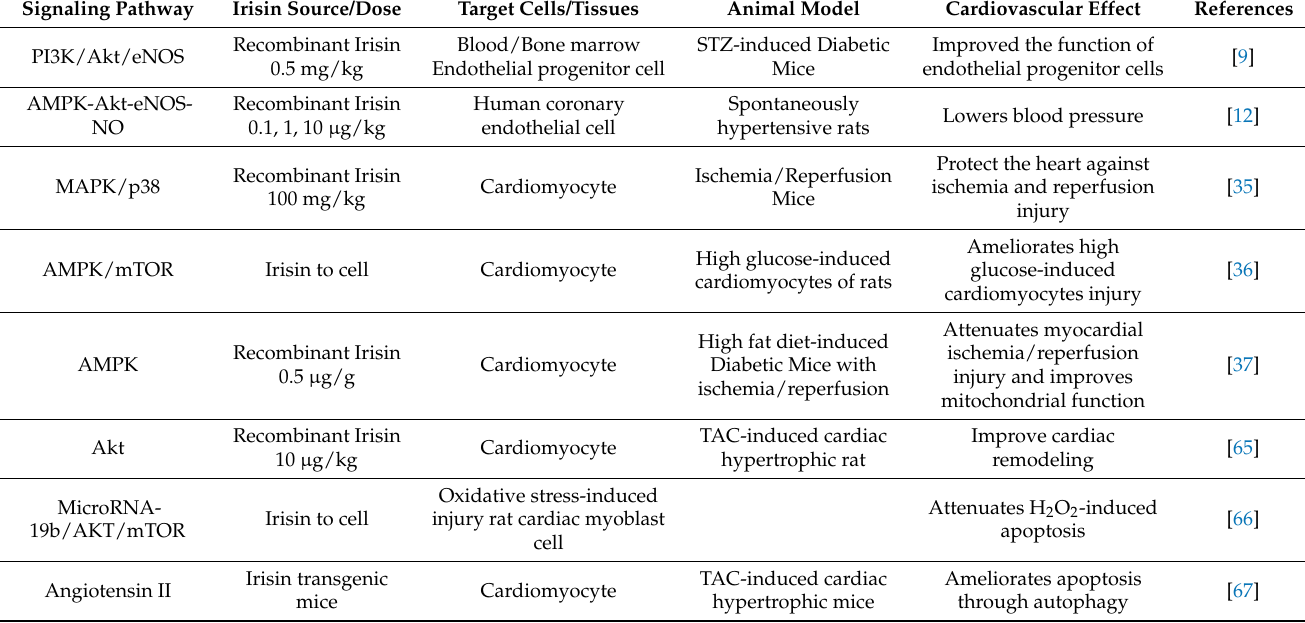
Table 1. Signaling pathways of irisin in cardiovascular effects. TAC, transverse aortic constriction; Nrf2, E2-related factor-2; STZ, streptozotocin; EndMT, endothelial-to-mesenchymal transition; MAPK, mitogen-activated protein kinase; AMPK, adenosine monophosphate-activated protein kinase; mTOR, mechanistic target of rapamycin; ULK1, serine/threonine- protein